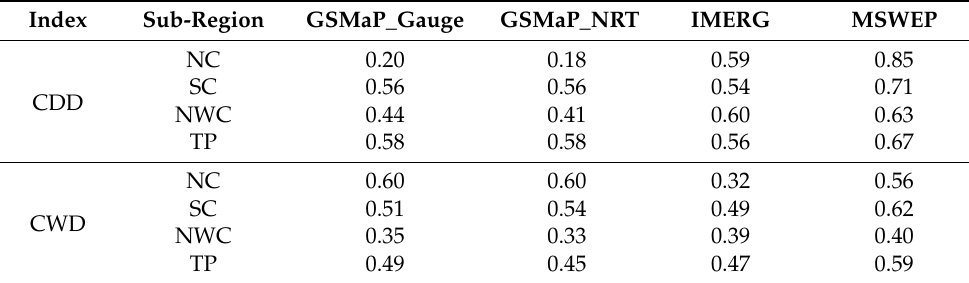
Table 4. The global BMI of persistent indices in four